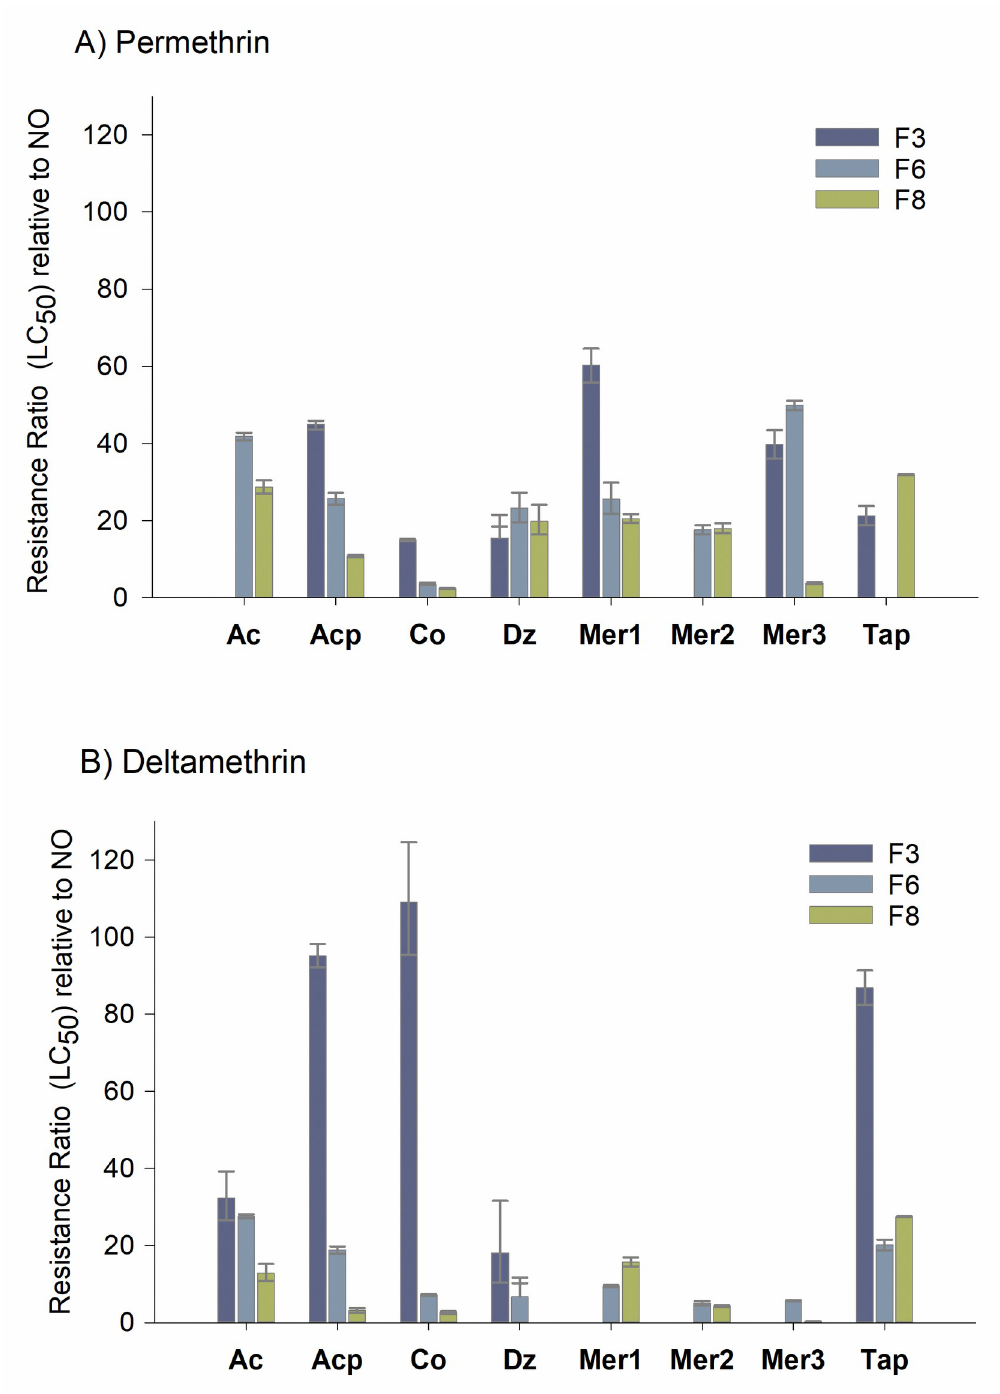
Fig 1. A) Resistance to permethrin in generations F 3 , F 6 and F 8 in absence of insecticides. Resistance ratios were calculated by dividing the LC 50 of our sites by the LC 50 determined for New Orleans. B) Resistance to deltamethrin in generations F 3 , F 6 and F 8 in absence of insecticides. Resistance ratios were calculated by dividing the LC 50 of our sites by the LC 50 determined for New